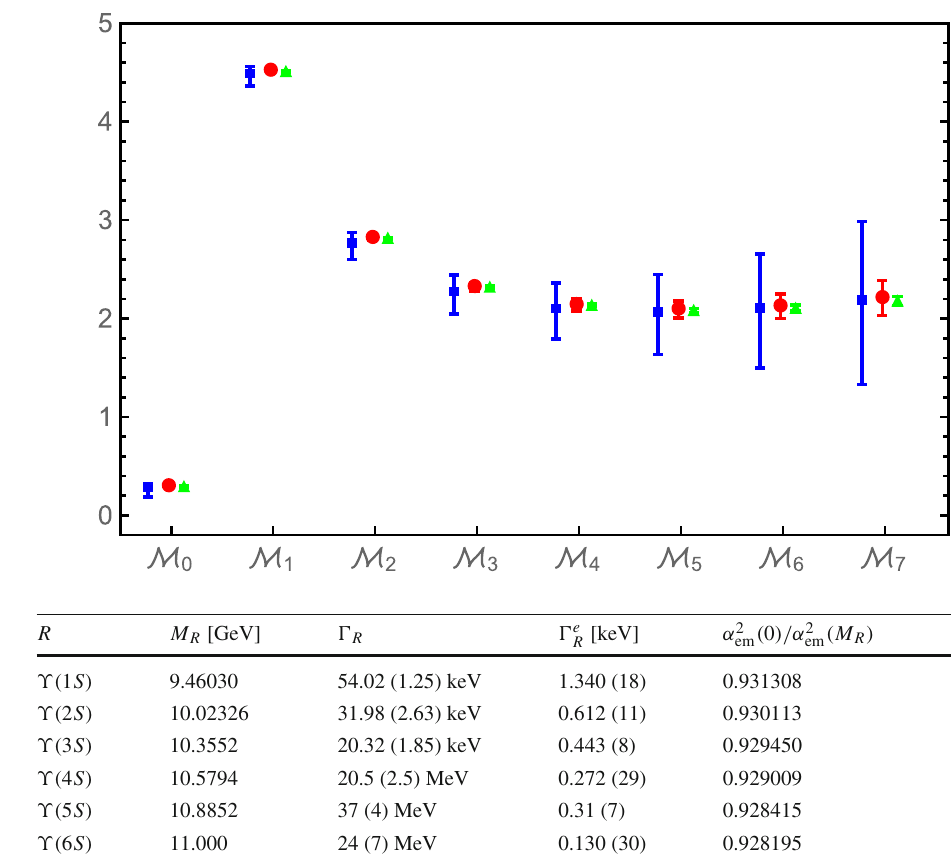
Fig. 1 The theoretical moments M pQCD n in Eq. (6) (multiplied by 10 2 n + 1 GeV 4 n + 2 ) for the reference value ˆ m ( ˆ m ) = 4 . 180 GeV at b b different orders in ˆ α s . Blue squares show results at O ( ˆ α s ) , red circles include O ( ˆ α 2 s ) terms, and green triangles refer to the full O ( ˆ α 3 s ) . The error bars are the truncation uncertainties from Eq. (12) at the given